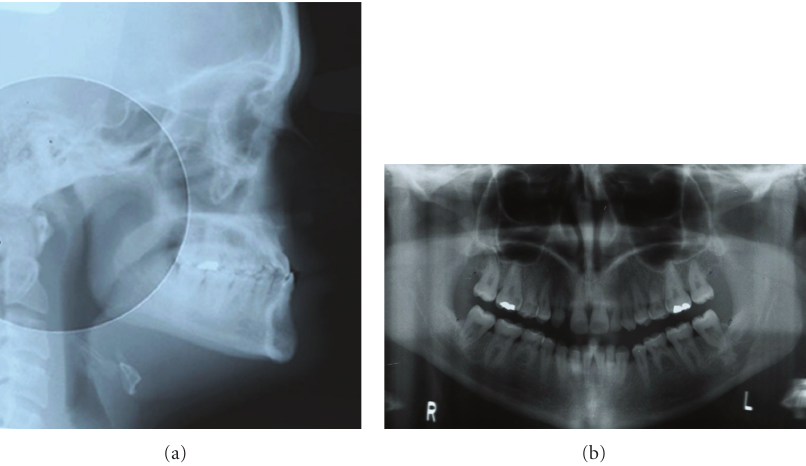
Figure 1: (a,b) Lateral cephalometric and panoramic radiographs of an adolescent with Down syndrome show typical skeletal disharmony, malocclusion, and permanent tooth